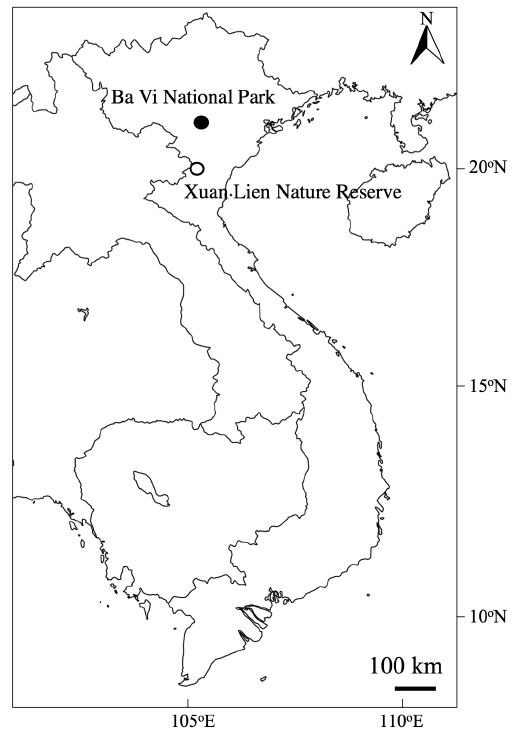
Figure 1. Collection sites of Quercus xuanlienensis Binh, Ngoc & Bon, Quercus disciformis Chun & Tsiang. and Quercus bella Chun &